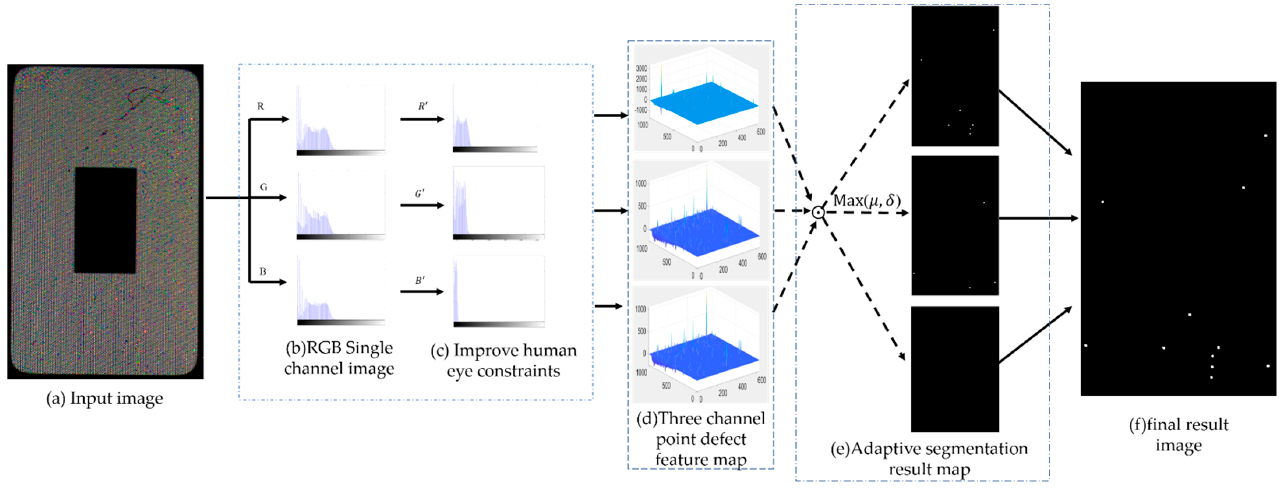
Figure 1. Algorithm